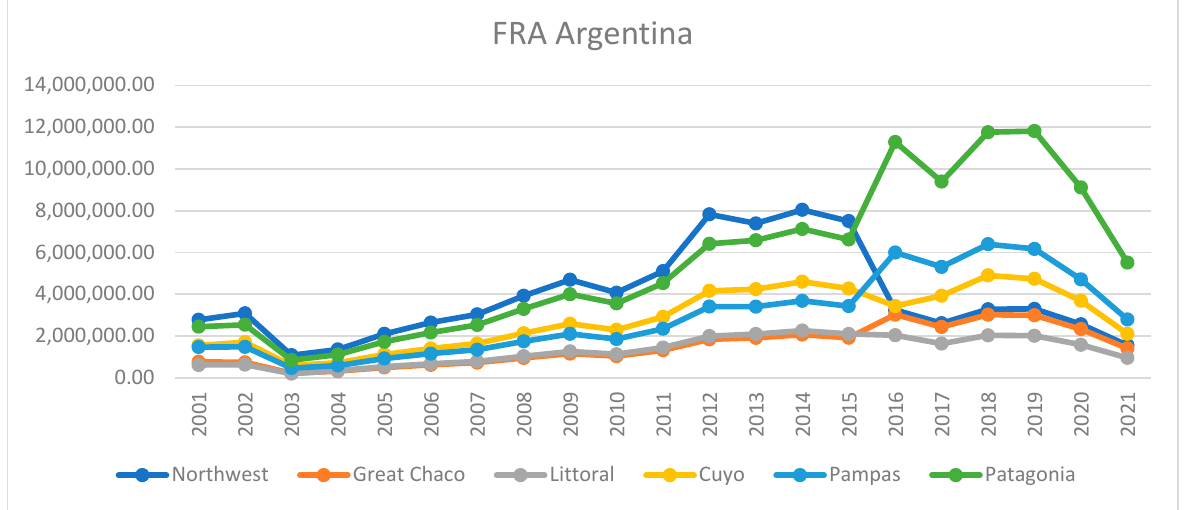
Figure 4. FRA Argentina (USD). Source: DNCFP.